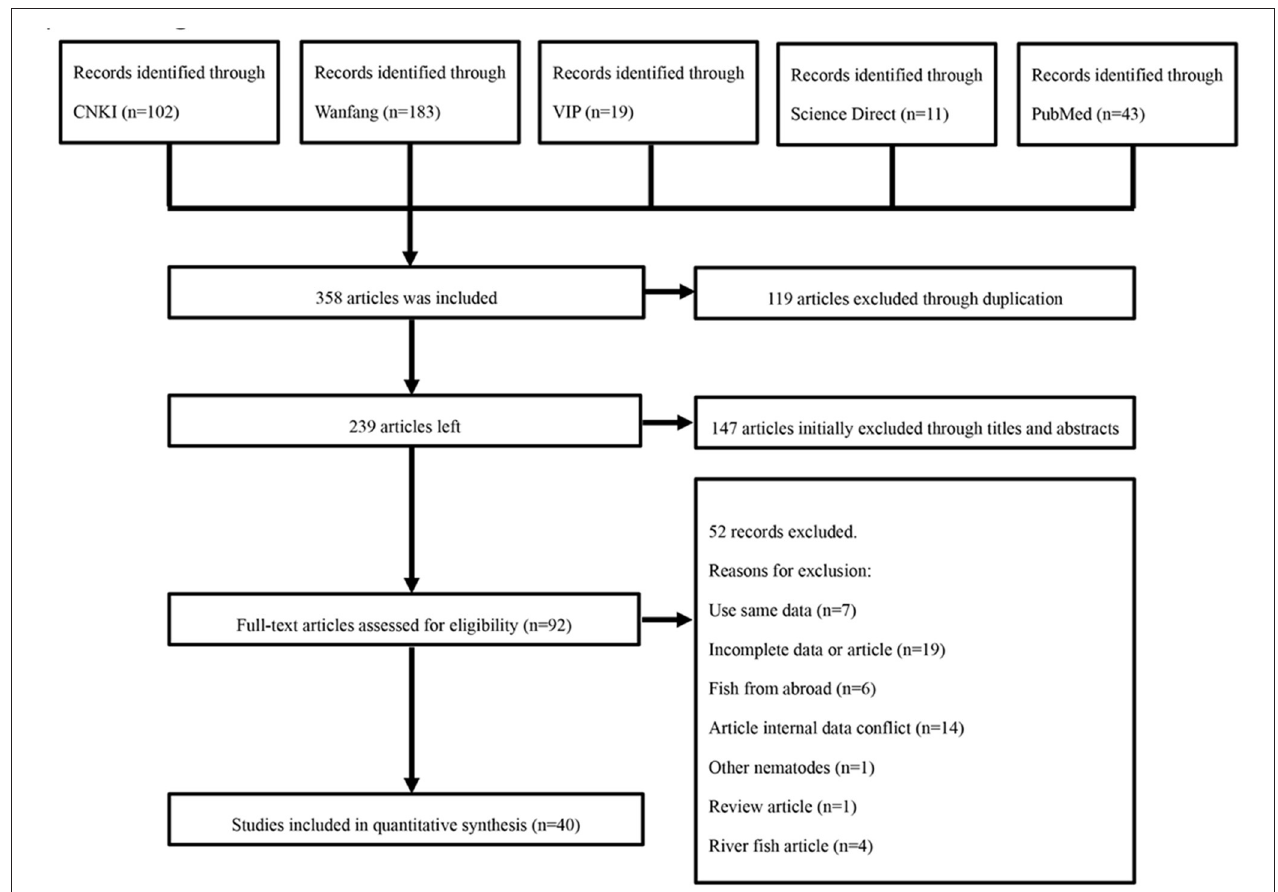
FIGURE 1 | Flow diagram of literature search and selection.